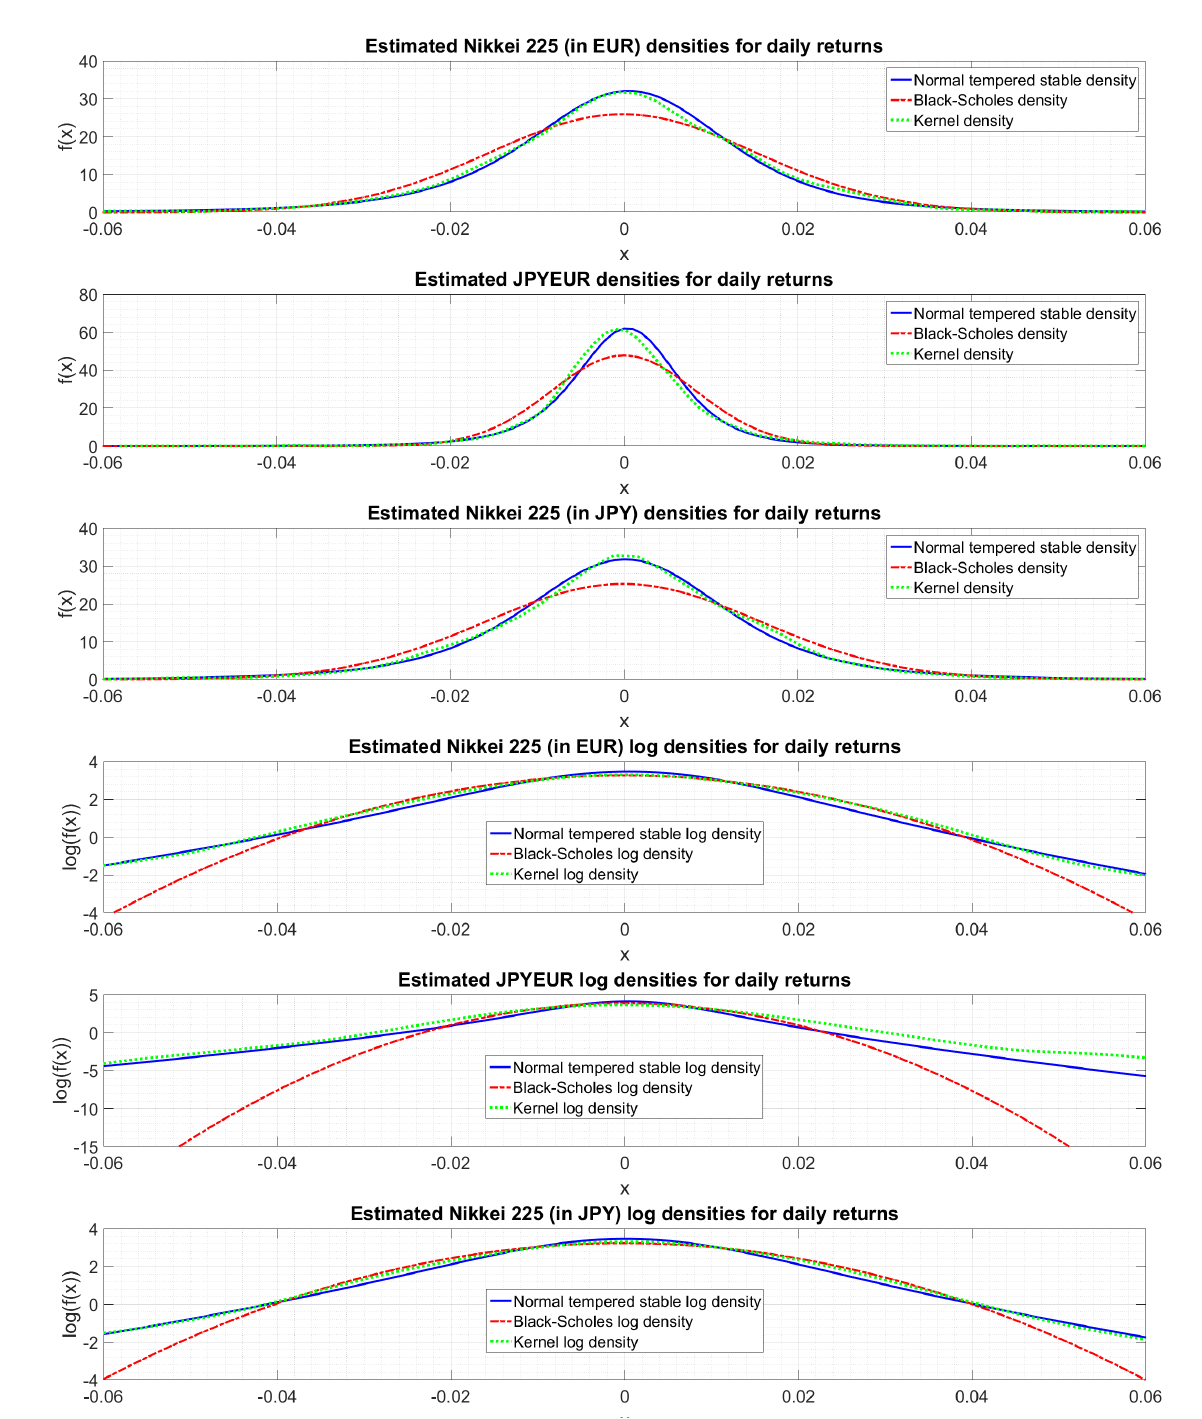
Figure 2. Estimated densities and log-densities based on the estimates reported in Table